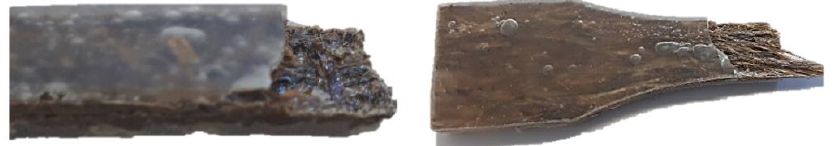
Figure 12. Visualization of fracture defects (delamination) on sandwich tensile specimens.